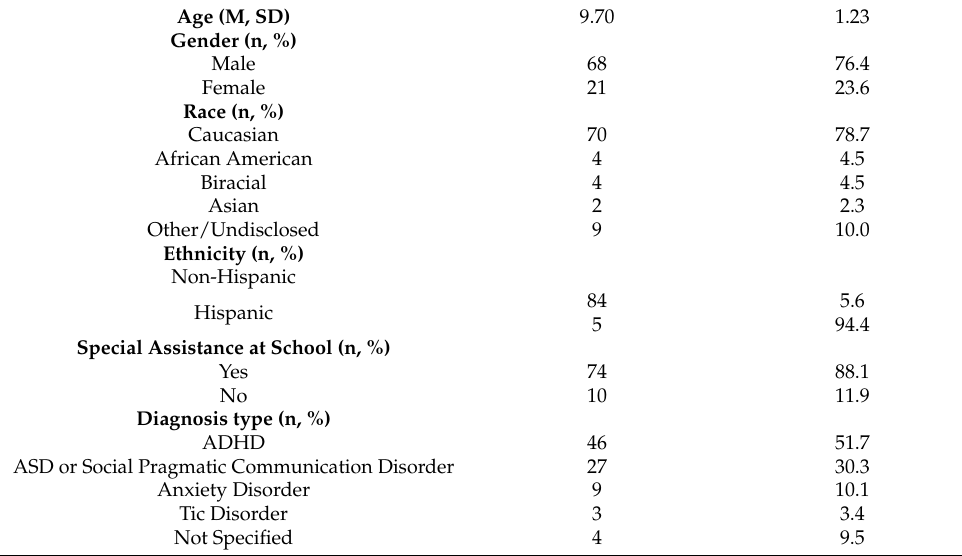
Table 1. Participant demographic